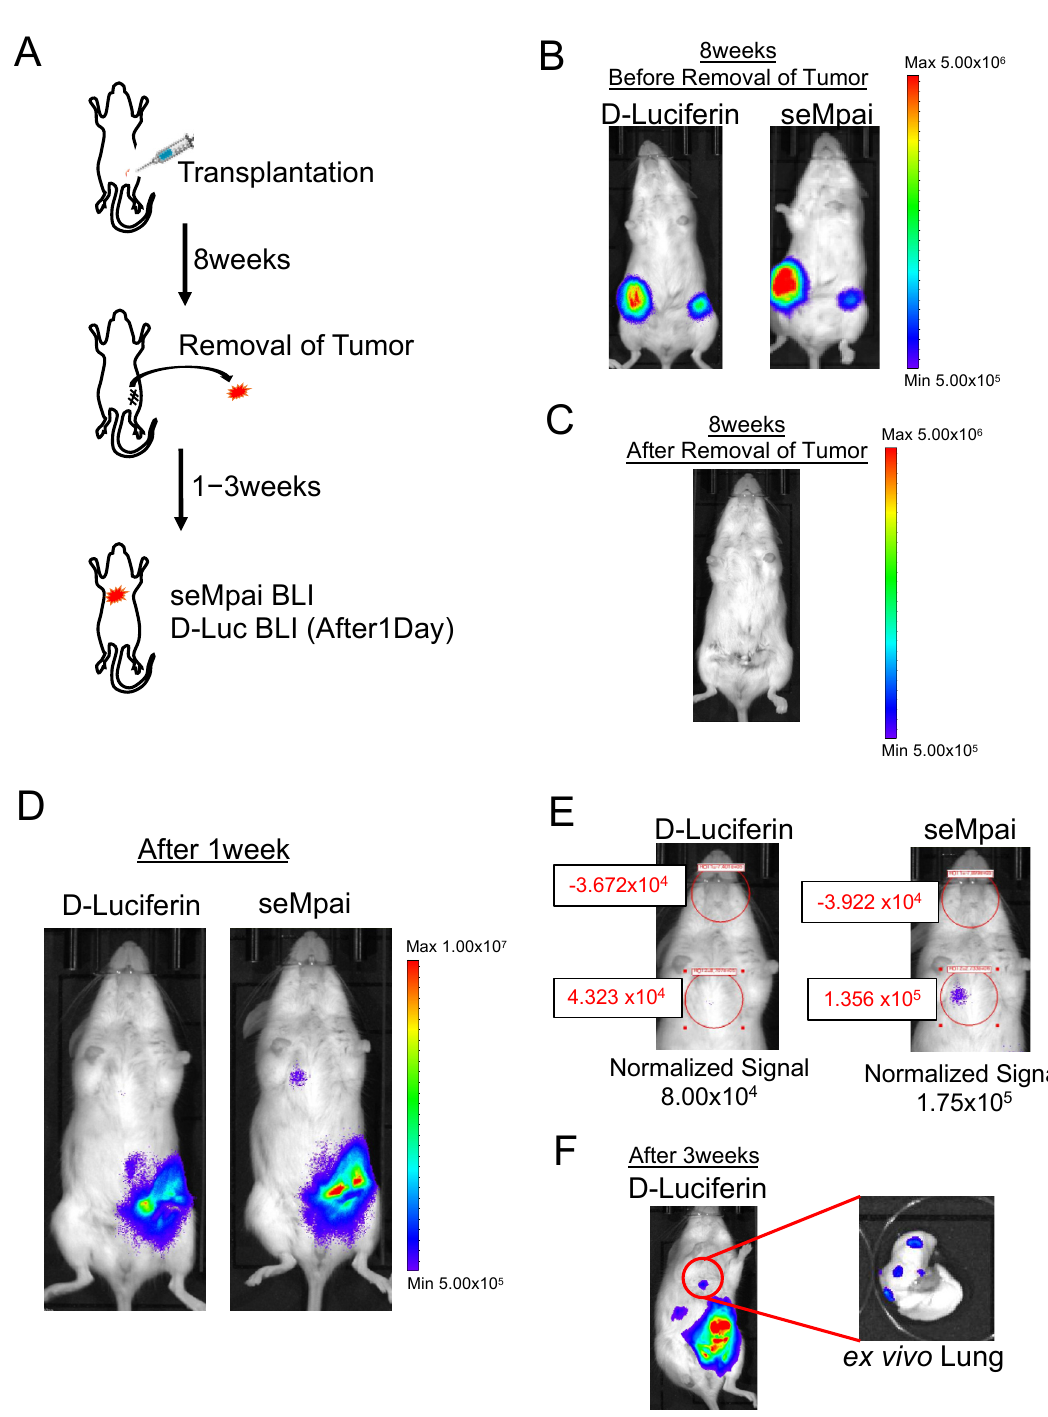
Figure 2. Detection of micro-metastases in the orthotopic transplantation model. Scheme of orthotopic transplantation using NMuMG-ERBB2-metastatic cells ( A ). Eight weeks after transplantation, comparative analysis of D-luciferin BLI and seMpai BLI. Before removal of the primary tumor ( B ) and after removal of the primary tumor ( C ). One week after the removal, comparative analysis of D-luciferin BLI and seMpai BLI. The same mouse was used to perform BLI of D-luciferin and seMpai ( D ). ROI measurement of micro-signal from the pleural lesion in D-luciferin BLI and seMpai BLI ( E ). seMpai could detect micro-metastases in the breast cancer metastasis model. Three weeks after removal, D-luciferin BLI could detect the micro-signal from the lung metastases ( F ). The scale bar’s unit is the radiance (p/s/cm 2 /sr).